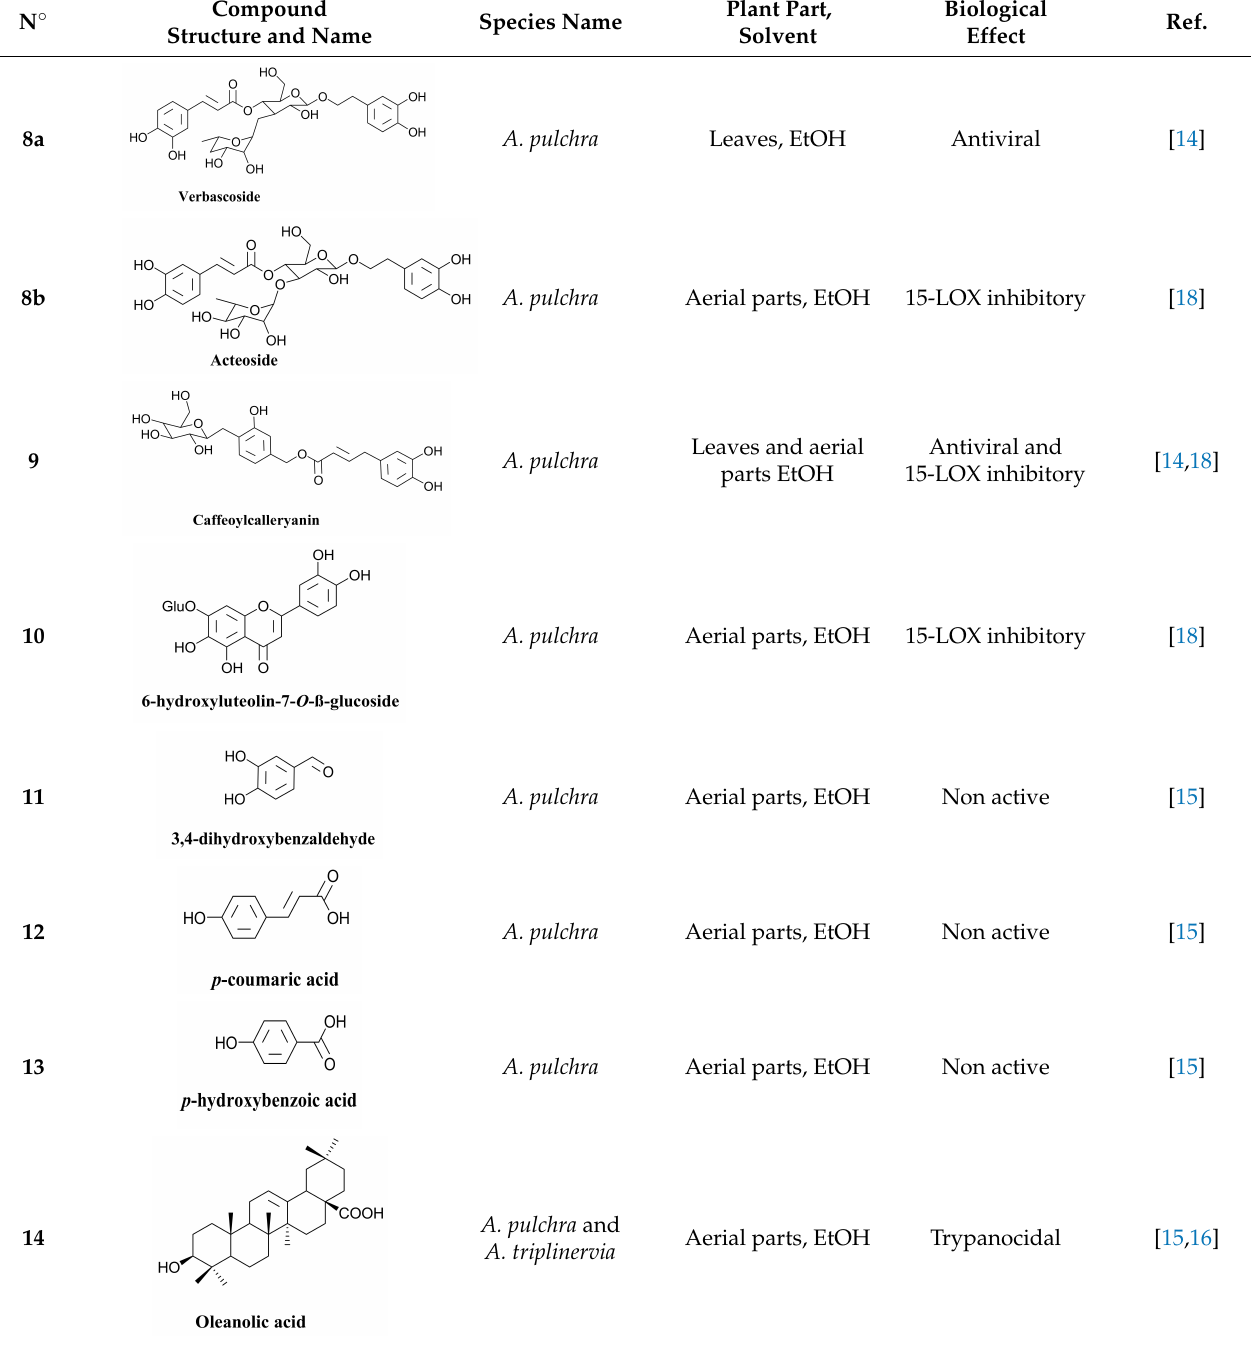
Table 2. Structure and bio-pharmacological properties of isolated compounds from A. pulchra